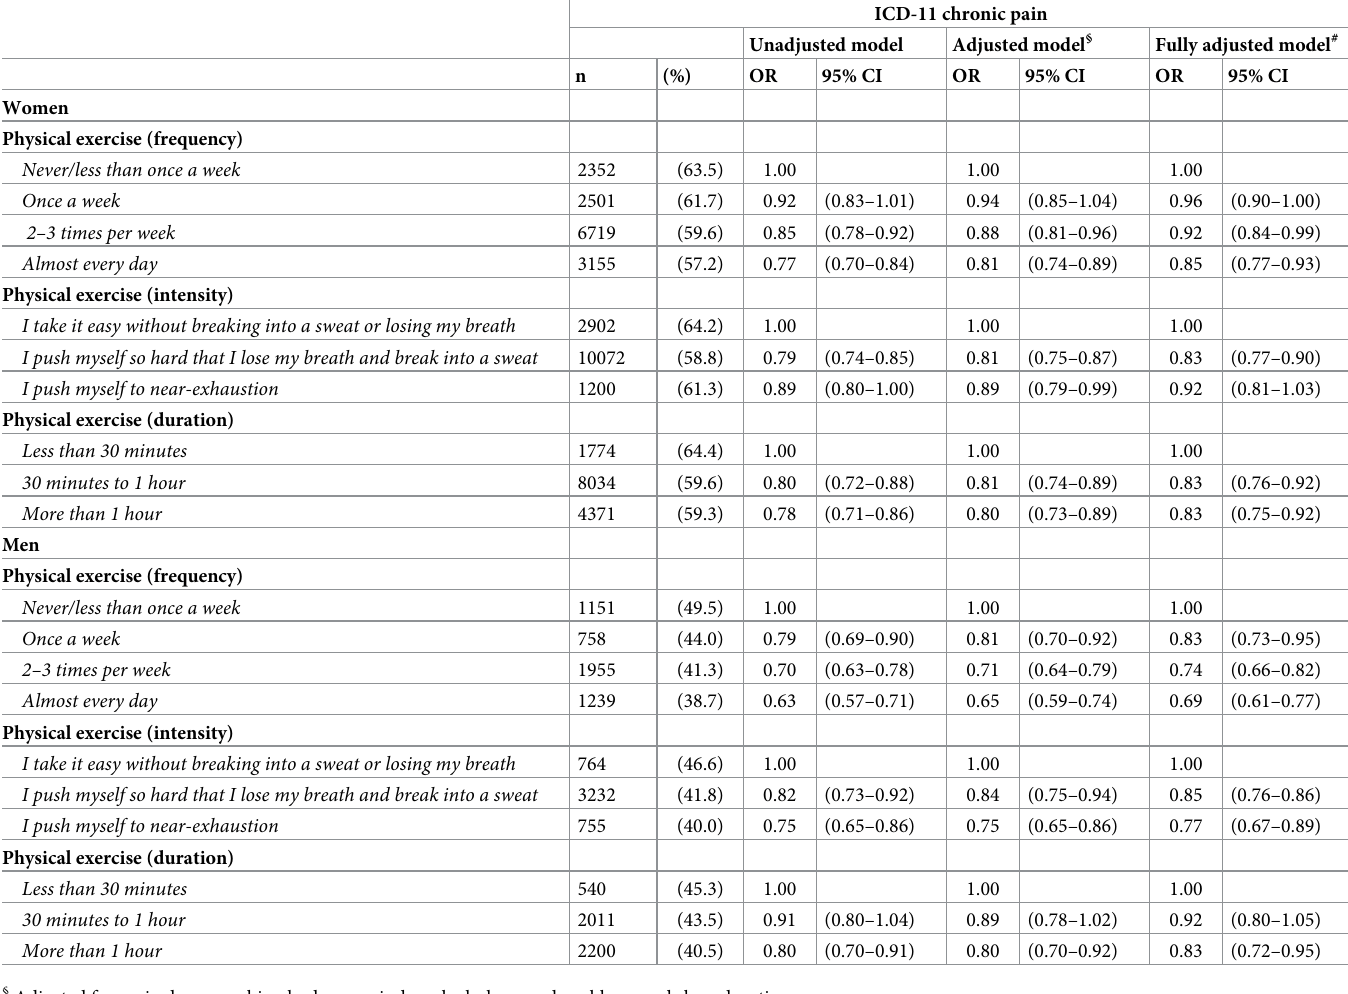
Table 2. Association between physical exercise and chronic pain in male and female university and college and university